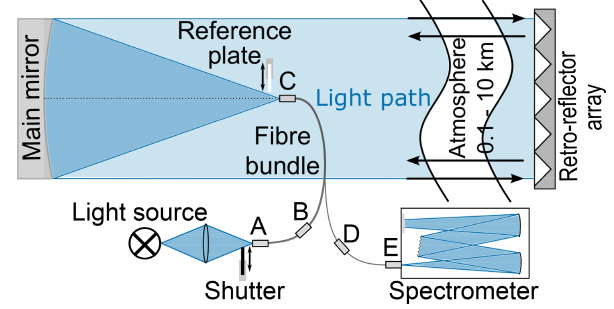
Figure 1. Components of a fibre-based LP-DOAS system consist- ing of a light source, a Y-shaped fibre bundle, a telescope for send- ing and receiving the light, a retro-reflector array, and a spectrome- ter. Adapted from Sihler